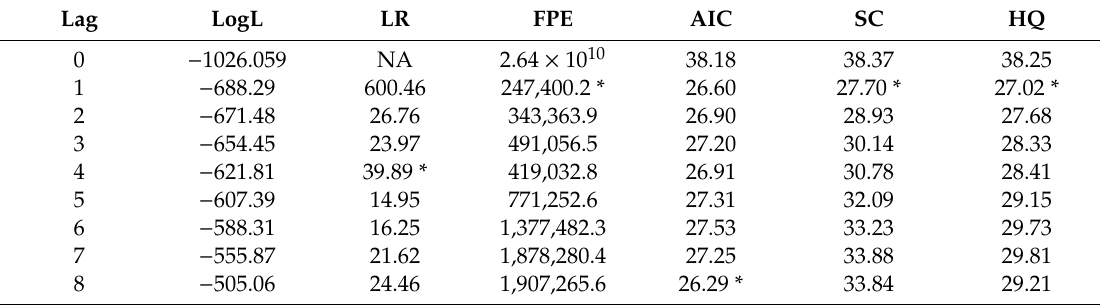
Table 2. VAR Lag order selection.